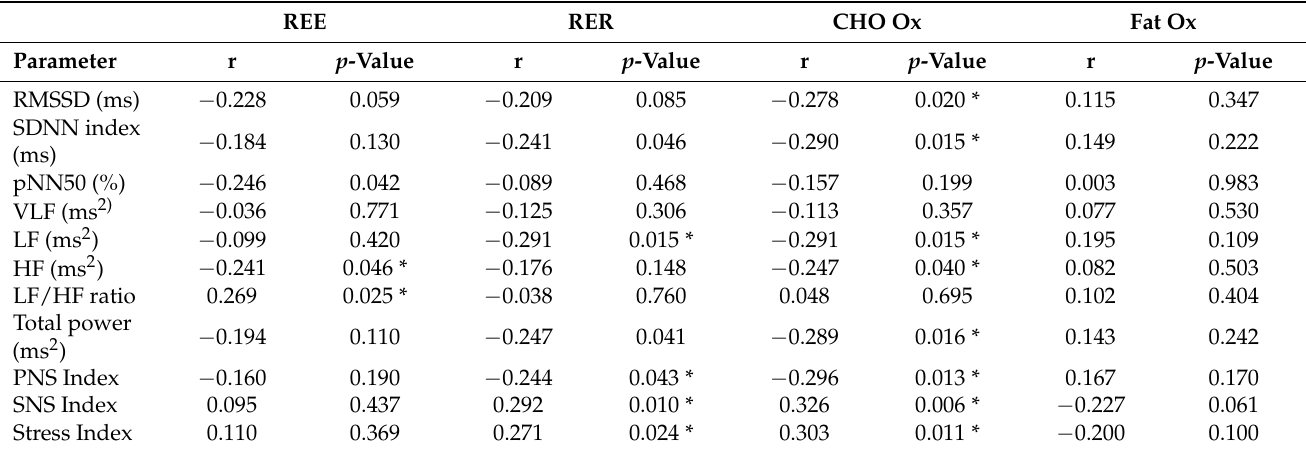
Table 3. HRV and metabolic parameter